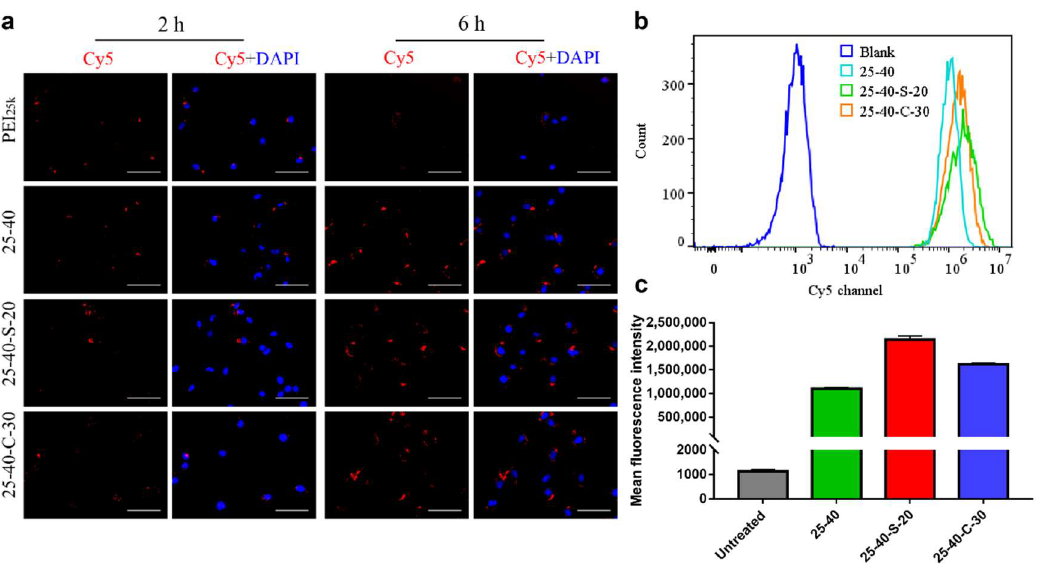
Figure 6. ( a ) Fluorescence images showed the intracellular distribution of H-zPEIs/Cy5-siRNA NPs. Scale bar: 75 μm ( b ) and ( c ) Cellular uptake of H-zPEIs/Cy5-siRNA NPs in HeLa-Luc cells determined by flow cytometry 4 h post-incubation.